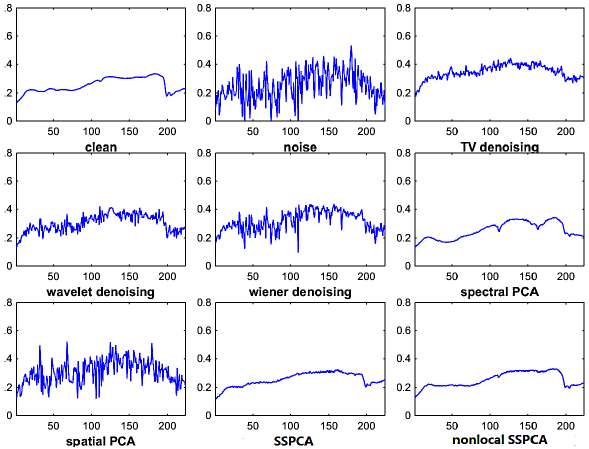
Figure 5. Spectra at pixel (60,60) of the simulated data, before and after denoising by different